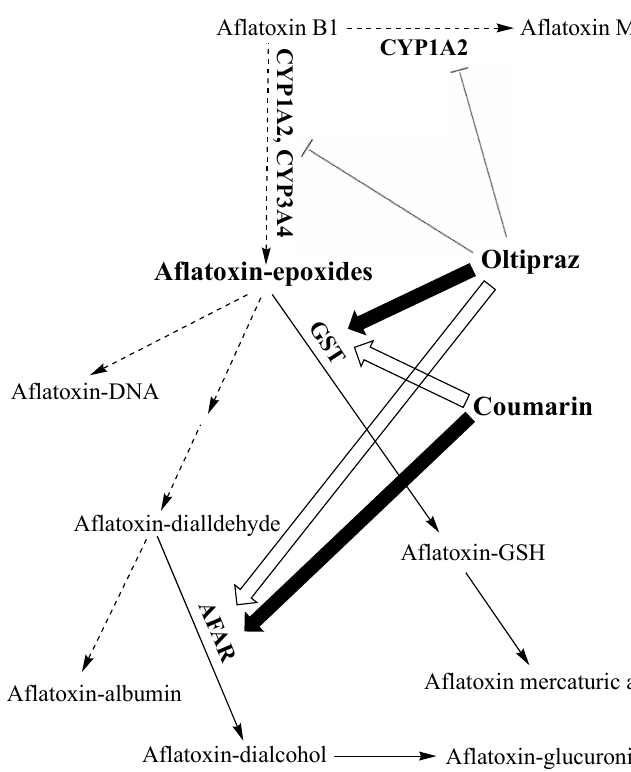
Figure 3. Action of oltipraz and coumarin on the metabolism of aflatoxin B1 against aflatoxin-induced hepatocarcinogenicity. The dominant action of each agent is indicated by a large filled arrow while a lesser inducing effect is indicated by large hallow arrows; T-shaped lines indicate inhibition of the enzymes; dashed arrows indicate reduced rate of the reaction; plain arrows indicate the routes favored by the action of the inducers [127,143]. (For abbreviations, see captions of Figure 1).